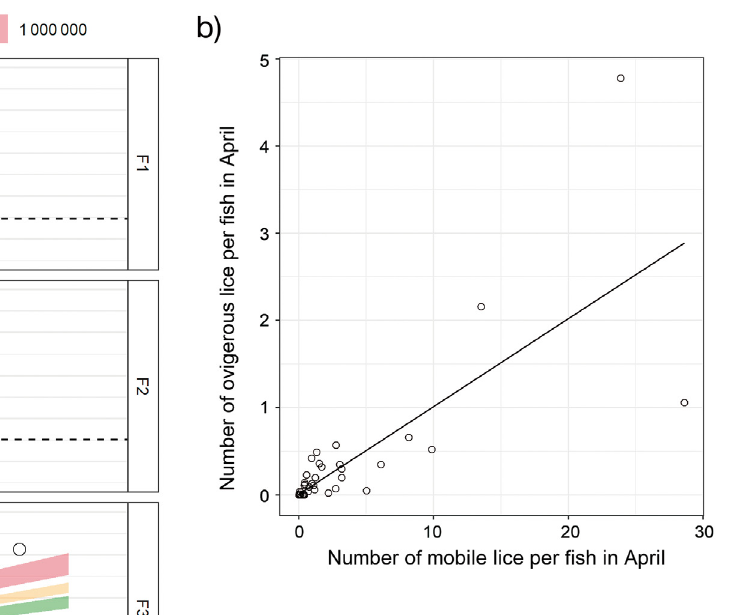
Fig. 6. (a) Contribution of individual louse infes tation rate ( x -axis) and the number of salmon stocked (Farm_num: coloured bands at values taken across the continuous range of the variable) on salmon farm sites F1 to F4 (see Fig. 1) to standardised total number of lice on the farm ( y -axis). The dashed line shows the observed 50 th percentile of standard- ised total number of lice on the farm site for each system (F1: Ballynahinch, F2: Dawros, F3: Erriff, F4: Eany and Eske). The rate of individual mobile louse infestation required to maintain the standardised total lice count on the farm site below this baseline can be read from the x -axis. (b) Corre- sponding rate for ovigerous lice can be approximated from the relationship between number of mobile and ovigerous lice for all study river